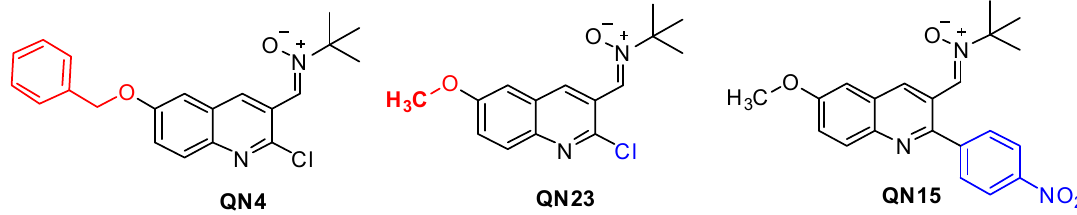
Figure 3. Structure of QN23 and the most potent neuroprotective agents QN4 and QN15 identified in this